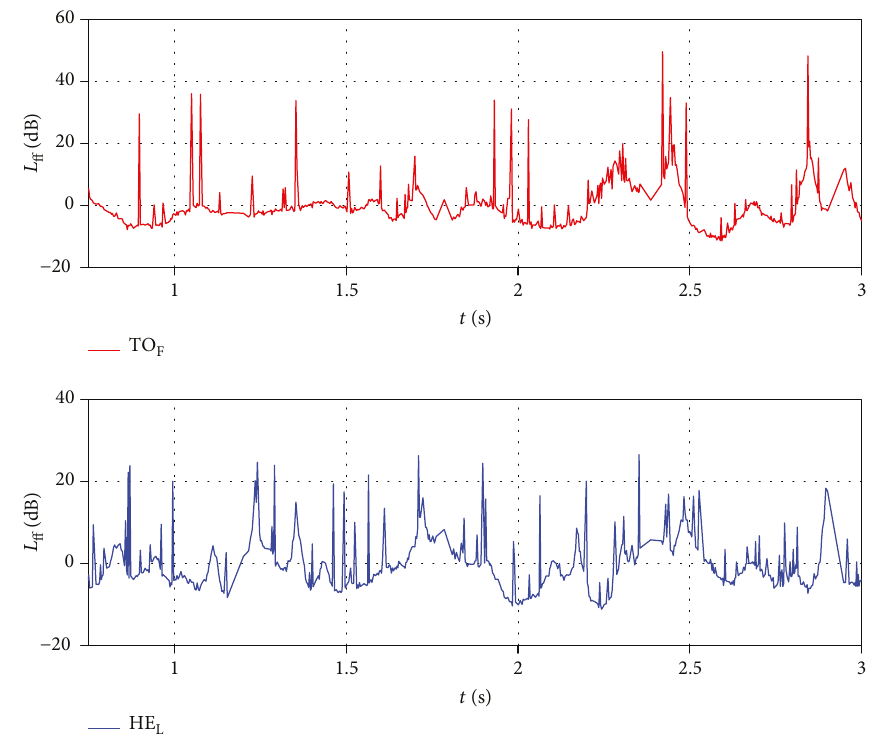
Figure 7: Exemplary graph of the fast fading component in a single realization of scenario for